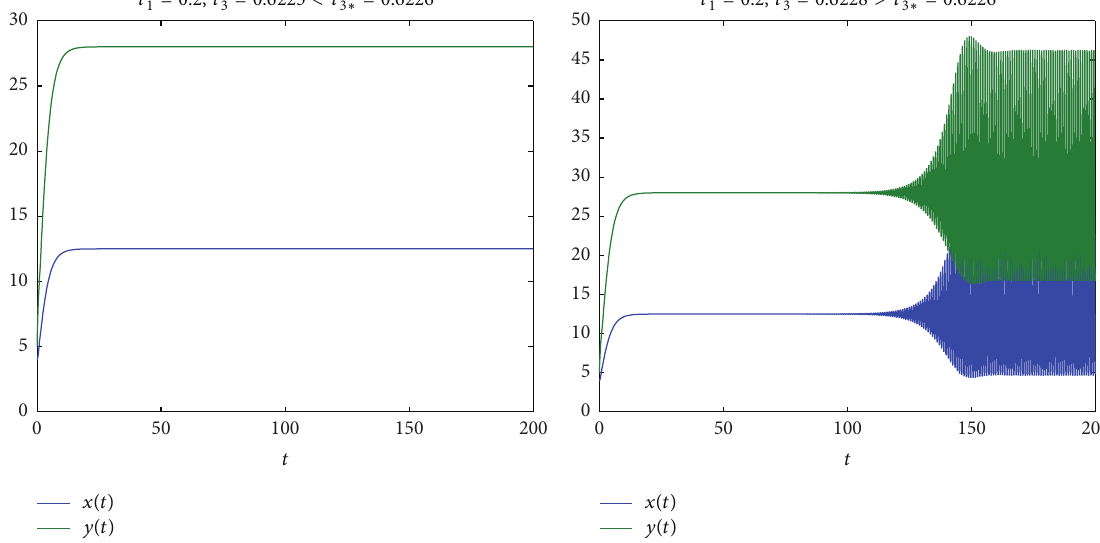
Figure 7: MATLAB simulation shows that the positive equilibrium of system (115) is locally asymptotically stable for 𝜏 3 = 0.6225 < 𝜏 3∗ = = 0.6228 > 𝜏 = 0.6226 with 𝜏 = 0.2 and initial value “4, 5.” 0.6226 and unstable for 𝜏 3 3∗ 1